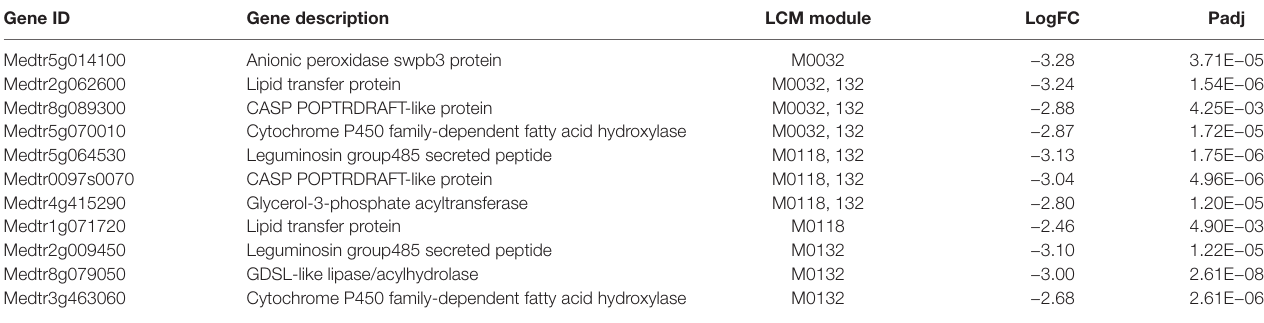
TABlE 3 | Genes assigned to modules consisting entirely of down-regulated genes at 48 h post-inoculation (48D). If a gene appeared in multiple modules, only the last digits of the number are listed for the additional modules. LogFC is X, Padj is